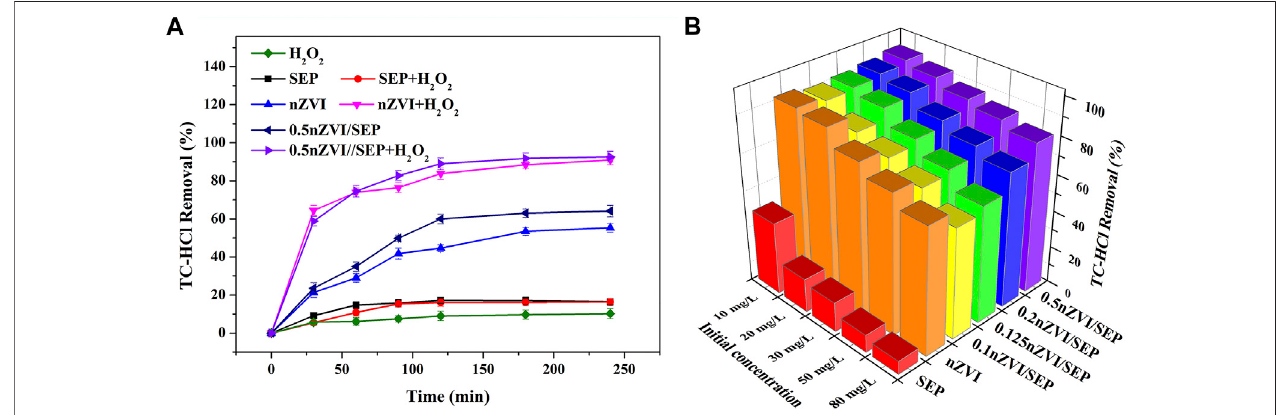
FIGURE7|(A) TC-HClremovalindifferentsystems, (B) TC-HClremovalef fi ciencybydifferentcatalysts.(Experimentalconditions:TC-HClconcentration (cid:1) 20 mg/ L, catalyst dosage (cid:1) 0.1 g/L, H 2 O 2 concentration (cid:1) 1 mM, pH (cid:1) 7, room